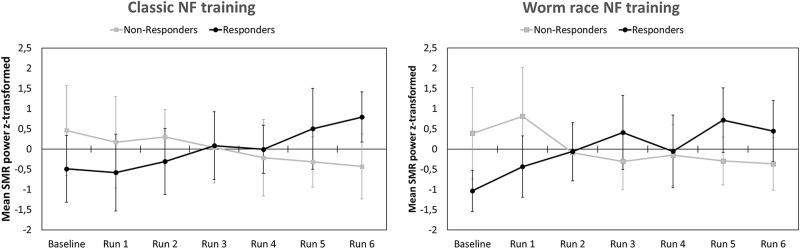
Means and standard deviations of z-transformed SMR (12–15 Hz) power (NF performance) for participants completing a classic NF training (Left) and participants completing a gamified NF training visualized by a worm race (Right). NF performance is presented separately for responders and non-responders.